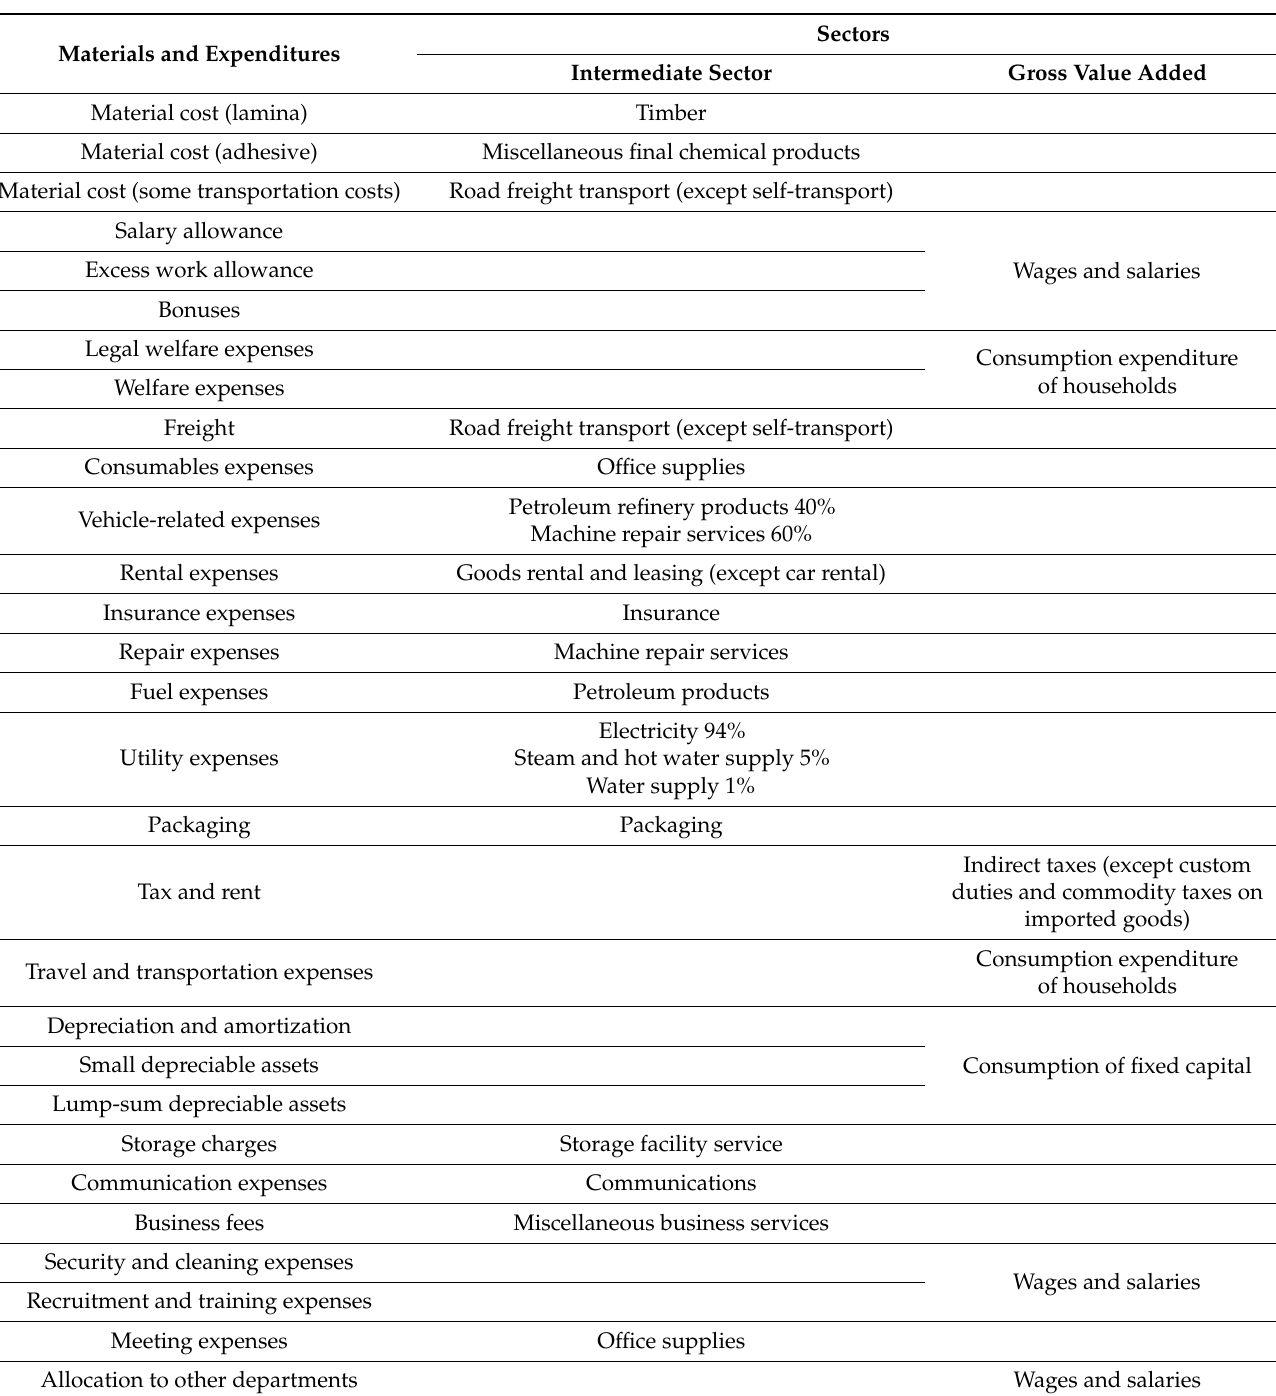
Table 1. Assigning expenditures to